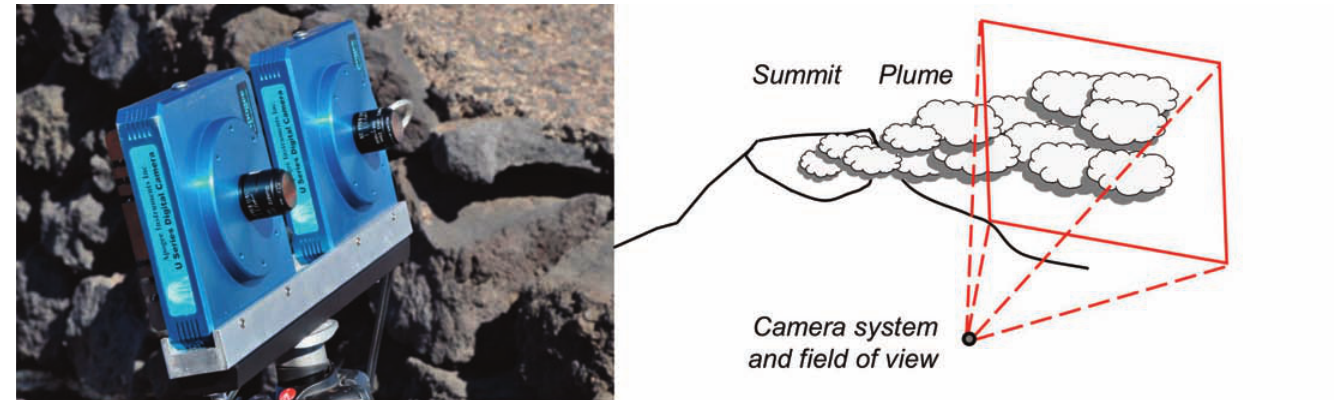
Figure 4. Left – Ultraviolet camera pair with bandpass filters at 310 nm and 330 nm, tripod-mounted during a field campaign on Mt. Etna. Right – Schematic configuration of a typical camera-viewing inclination, such that the field of view captures the plume from the side as it moves horizontally, downwind of the